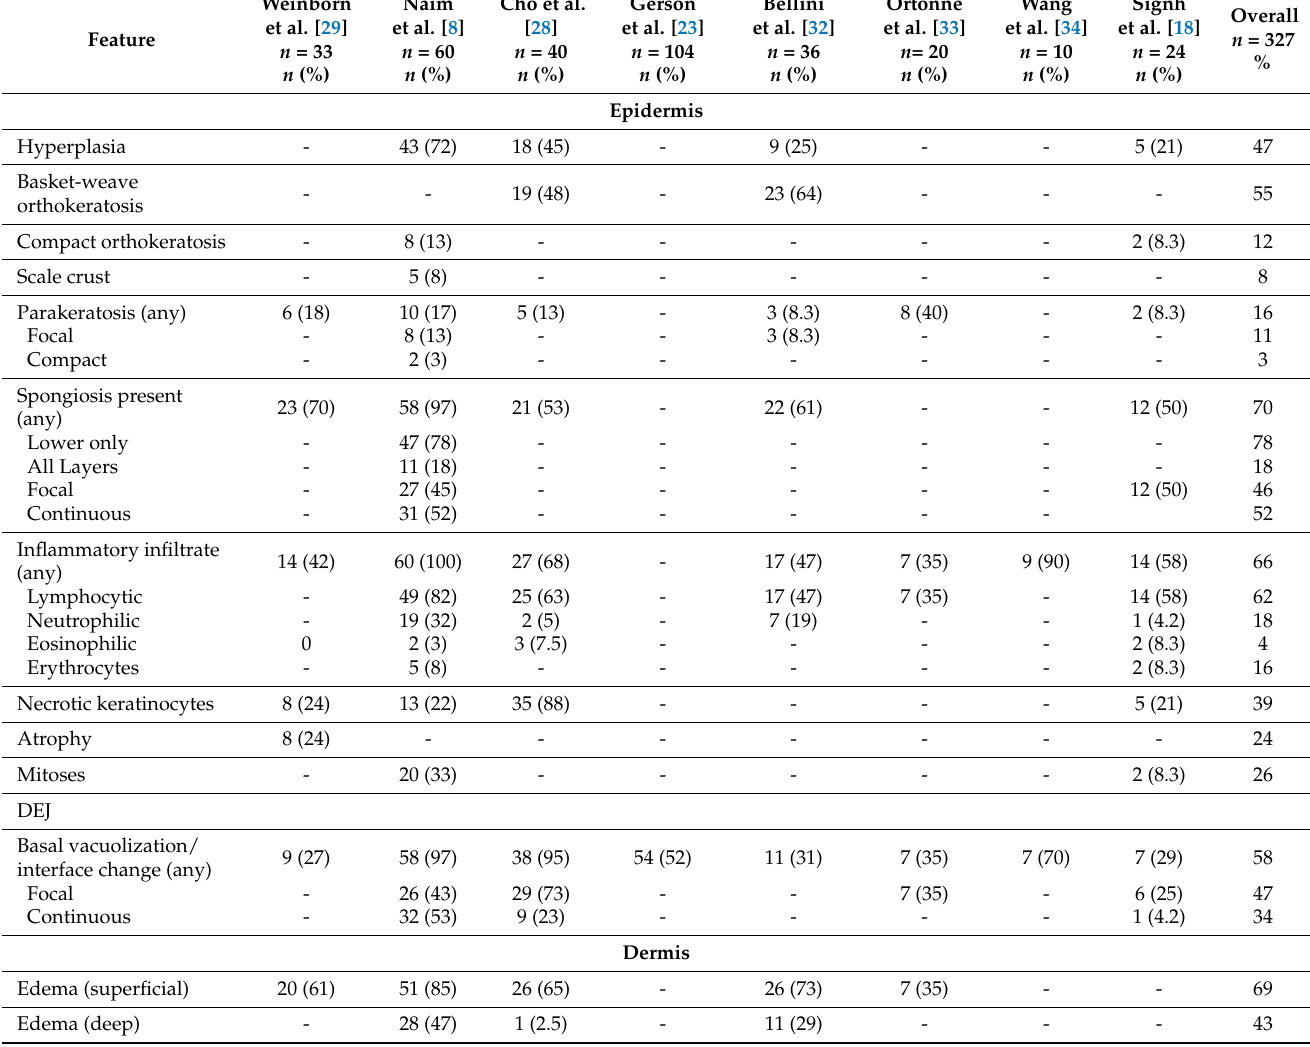
Table 1. Histopathologic features of 327 cases of maculopapular drug eruption from the